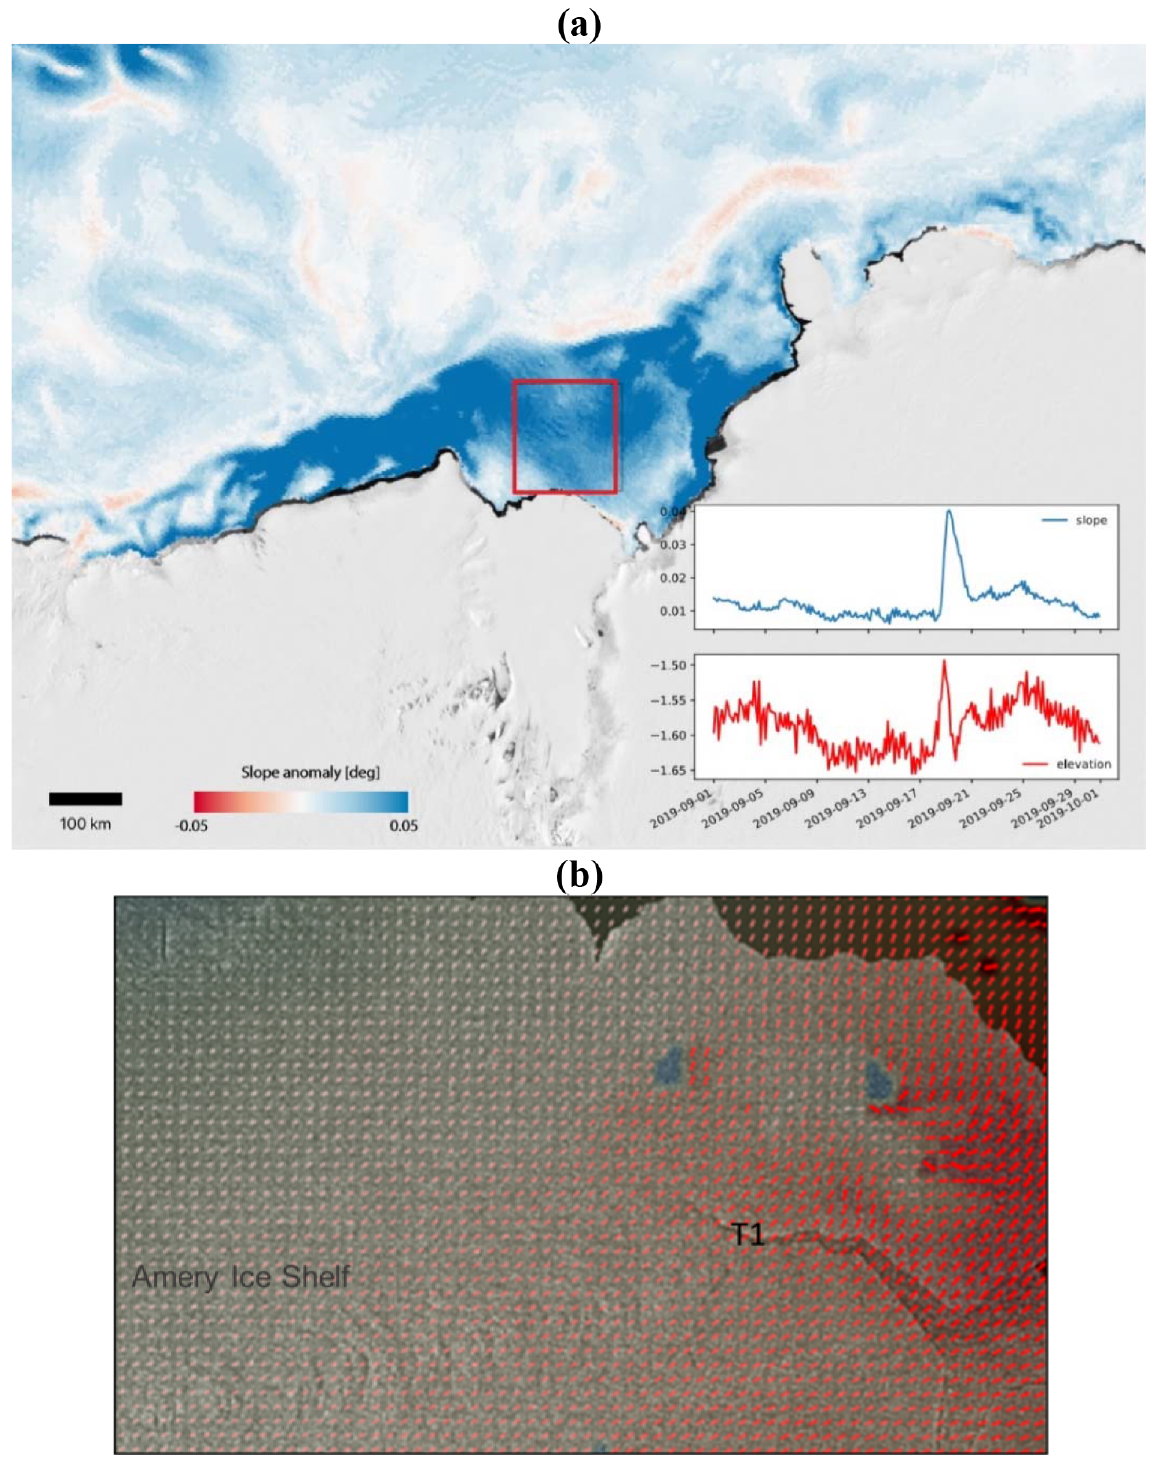
Figure 7. (a) Two-dimensional map of maximum ocean slope anomaly derived from the HYCOM (HYbrid Coordinate Ocean Model) reanalysis dataset during the period 17–20 September 2019 relative to September 2019 mean and time series of slope and surface elevation over the red bounding box showed on the map. (b) SAR image of the Amery Ice Shelf on 23 September 2019. The red vectors correspond to the ice displacement on 23 September 2019 (both velocity and direction) relative to 11 September 2019. Please note that the date format used in this figure is year month day